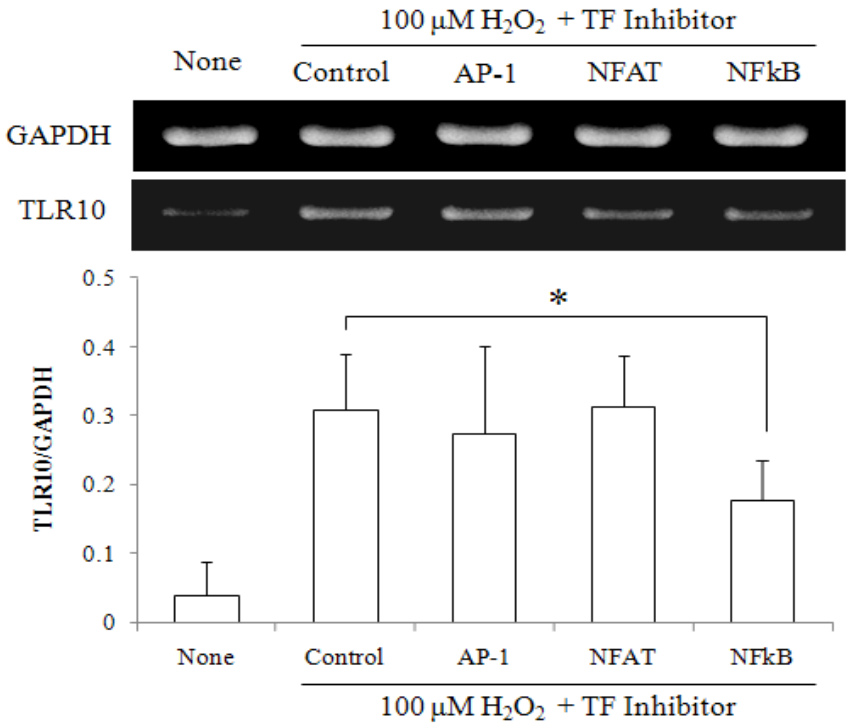
Figure 7. NF  B inhibitor suppressed H O -induced up-regulation of TLR10 expression. 2 2 A representative RT-PCR data showing TLR10 expression in THP-1 cells were treated with TF inhibitors for 30 min or 1 h before treatment with 100 μM H O . AP-1, NF-AT 2 2 and NF-  B were blocked with curcumin (Sigma, 10 μM, preincubation for 30 min), a cell-permeable NF-AT inhibitor peptide (Calbiochem, 4 μM, for 1 h) and quinazoline (Enzo Life Sciences Inc., 10 μM, for 30 min), respectively. The cells that had been maintained at 37 °C in 20% O in the presence or absence of the inhibitors were treated 2 with 100 μM H O for 1 h, harvested and then examined by RT-PCR analysis. The relative 2 2 expression of TLR10 was normalized by GAPDH using densitometric analysis. * P <